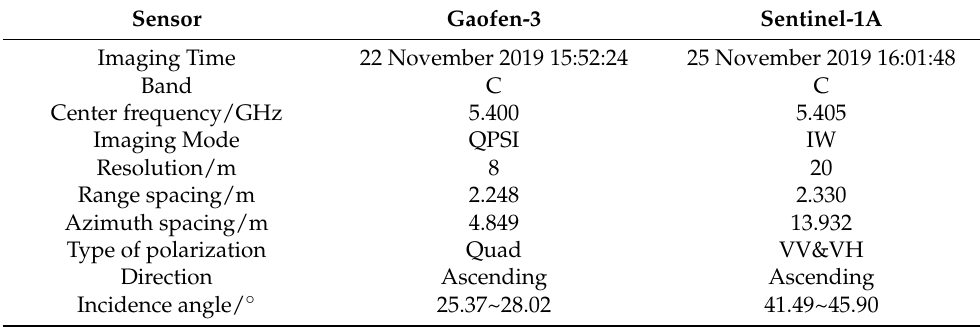
Table 3. Gaofen-3 and Sentinel-1A image parameters.